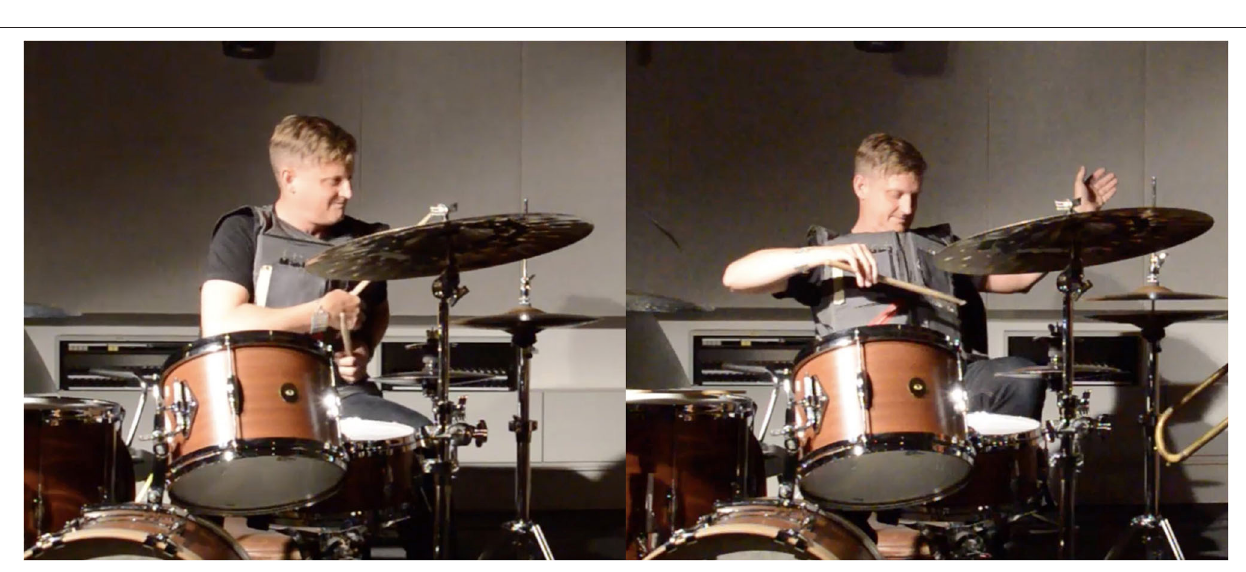
FIGURE 6 | Black plays the vest using unexpected gestures: he uses his drumstick on the